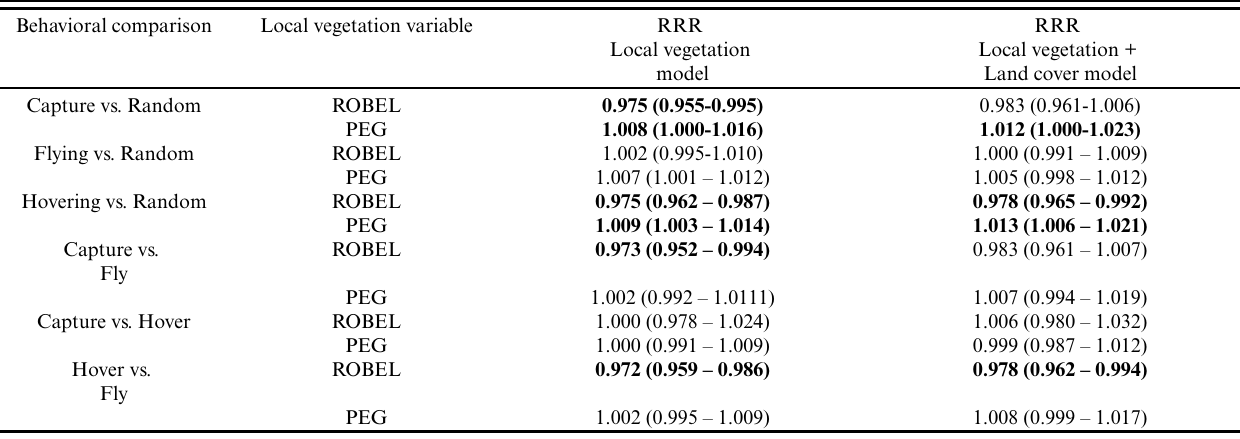
Table 6 . Risk rate ratios (RRR, where 1 indicates no difference) for ROBEL and percent exposed ground (PEG) between different behavioral comparisons. Bolded risk rate ratios have 95% confidence intervals that do not include